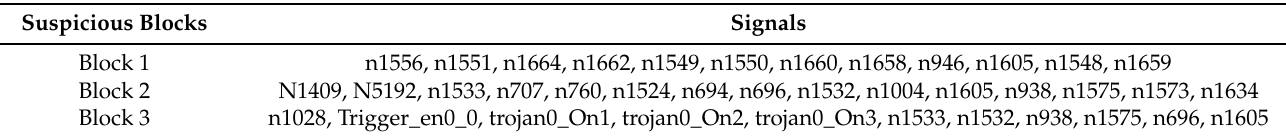
Table 2. Suspicious blocks of